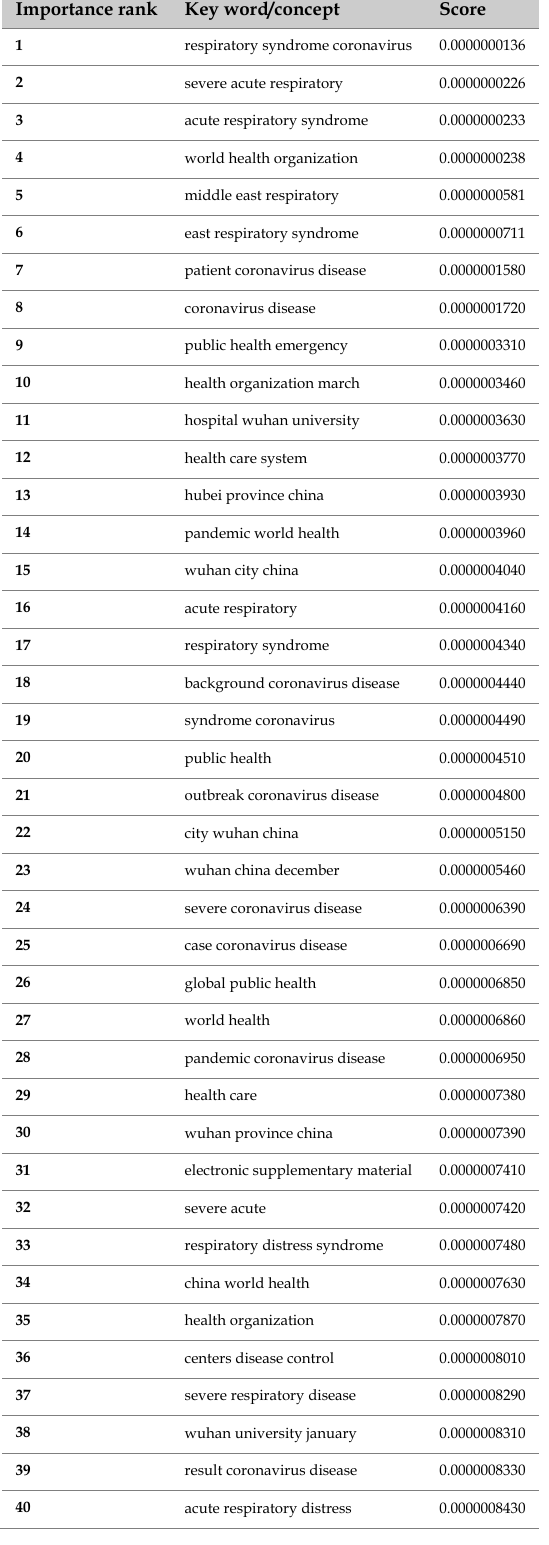
Table 3 The top 40 key words extracted from the dataset Importance